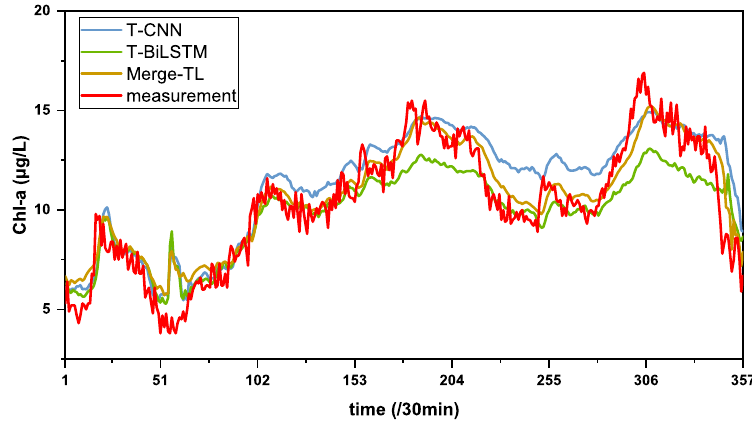
Figure 7. Results of the 2 h prediction for each model at the site S8, where the total number of the prediction data points is 357 and the corresponding time period is from 13:30 on 24 August to 23:30 on 31